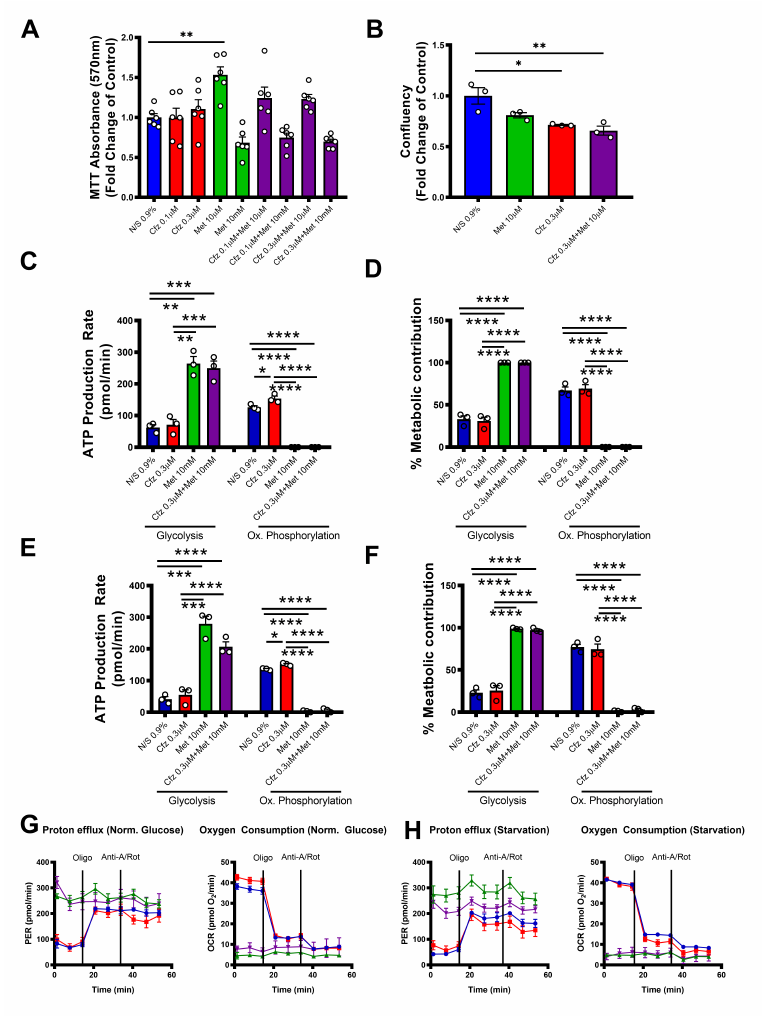
Figure 7. Carfilzomib and Cfz + Met do not induce cytotoxicity in senescent human aorta